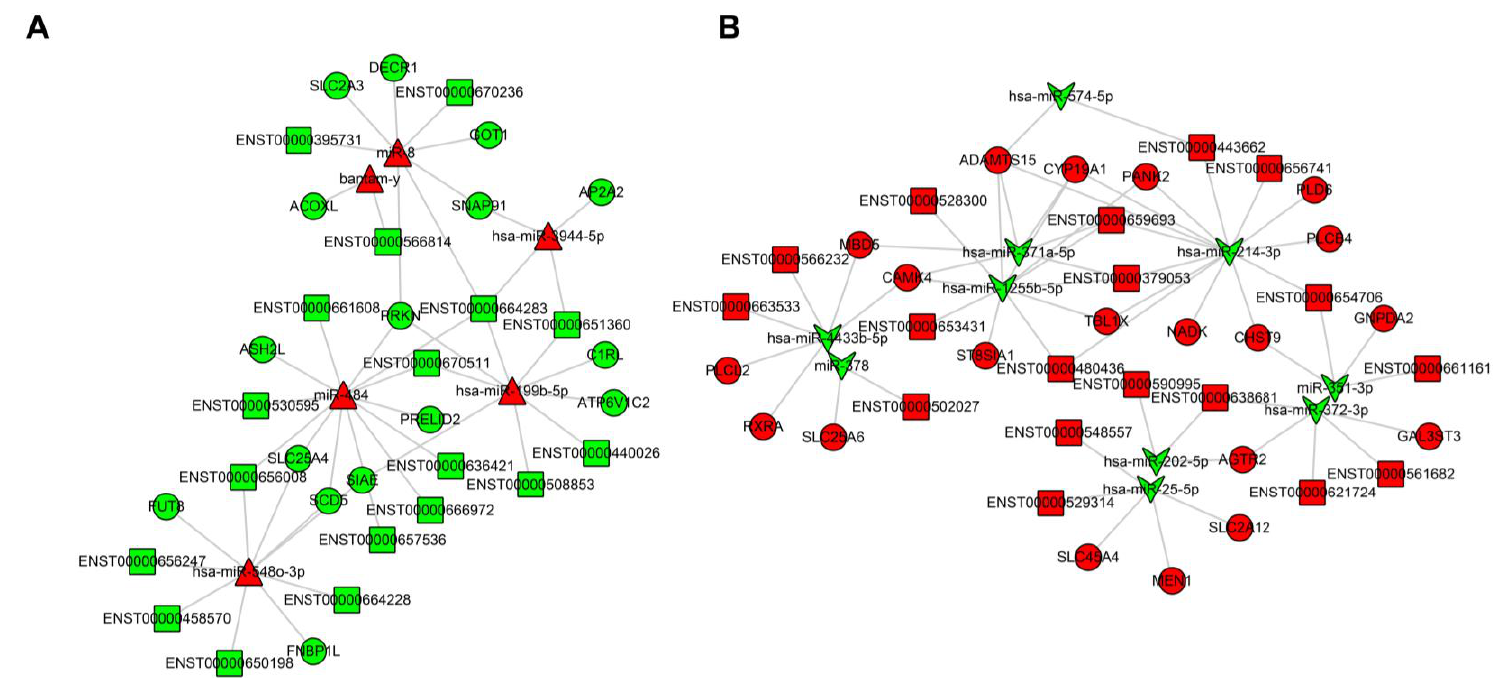
Figure 4. Metabolism-associated lncRNA–miRNA–mRNA interaction network for T2DM. ( A ) Red triangles represent up-regulated miRNAs, green squares represent down-regulated lncRNAs, and green circles represent down-regulated mRNAs; ( B ) green concave quadrilateral represent down-regulated miRNAs, red squares represent up-regulated lncRNAs, and red circles represent up-regulated mRNAs. The lncRNA-miRNA-mRNA regulatory network base on the DEGs in T2DM and was screened by correlation analysis and hypergeometric distribution tests. T2DM, Type 2 Diabetes; MRNA, messenger RNA; LncRNA, long noncoding RNA; MiRNA, microRNA.